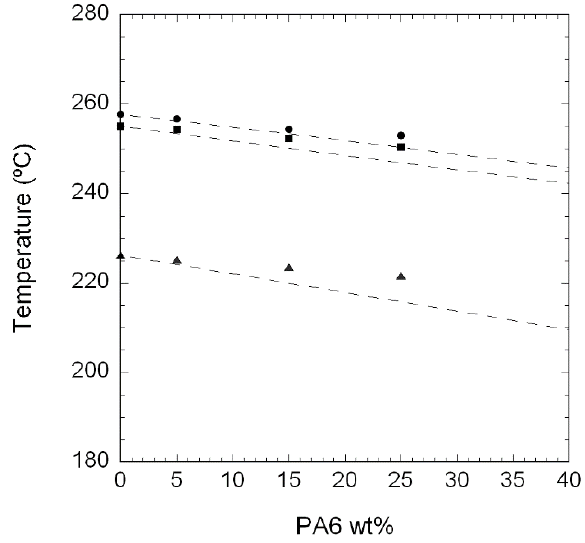
Figure 4. T c ( ▲ ) and T m values (first (●) and second ( ■ ) heating scans) of neat PA410 and PA6 and of Figure 4. T c ( (cid:78) ) and T m values (first ( ) and second ( (cid:4) ) heating scans) of neat PA410 and PA6 and of 95/5, 85/15 and 75/25 PA410/PA6 blends. 95/5, 85/15 and 75/25 PA410/PA6